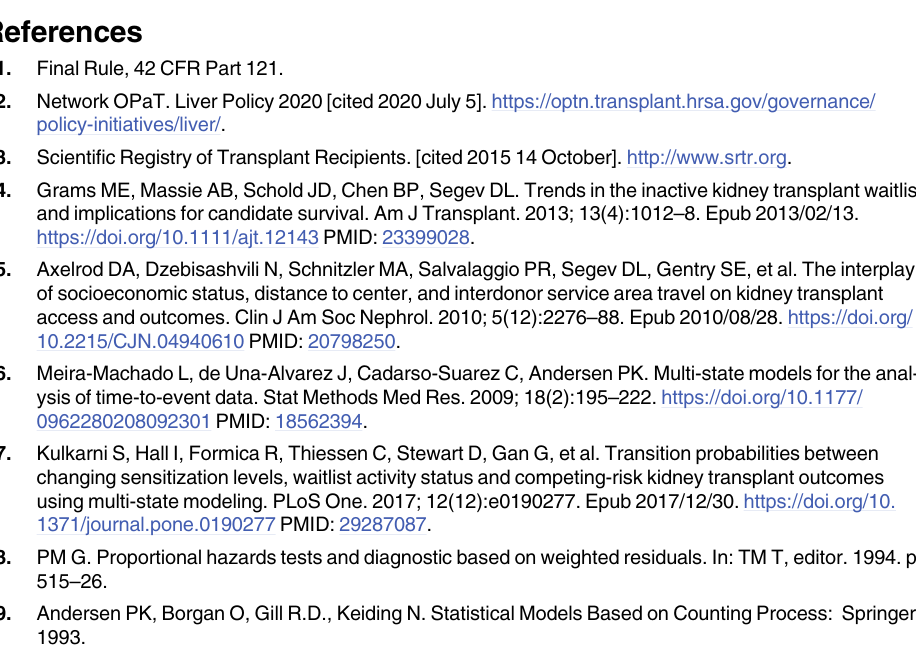
S6 Table. Detailed patient demographics of individuals experiencing inactivity during the follow-up